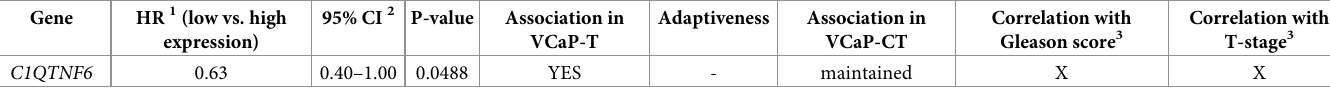
Multivariate Cox regression analysis for the genes was performed on the cohort of The Cancer Genome Atlas Prostate Adenocarcinoma data. Correlations of clinical characteristics and expression levels of the genes were assessed with Fisher’s exact test. 1 Hazard ratio for biochemical relapse or clinical tumor progression. Calculated with Cox regression.